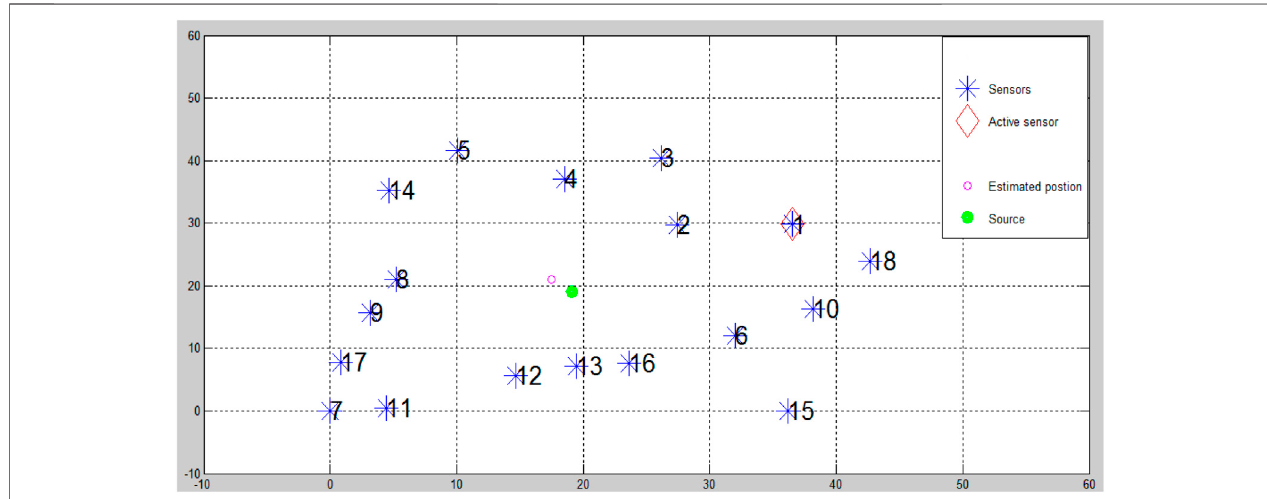
FIGURE 4 | Matlab Experiment Setup (Sensor and radiation source